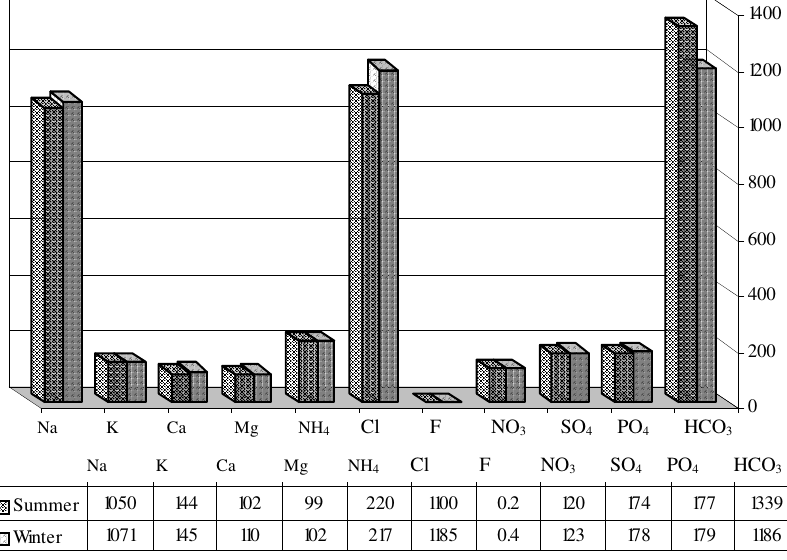
Figure 3. The average concentration of the major cations and anions for wastewater effluent for both